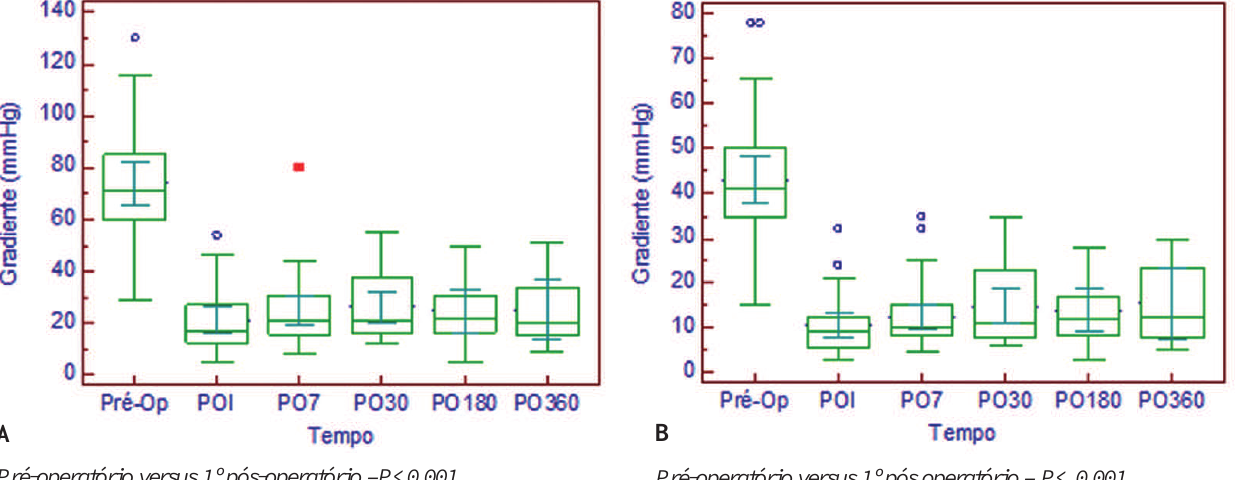
Fig. 4 – A. Gradientes transvalvares aórticos de pico no pré, 1º, 7º, 30º, 180º, 360º pós-operatório. B. Gradientes transvalvares aórticos médios pré, 1º, 7º, 30º, 180º, 360º pós-operatório.